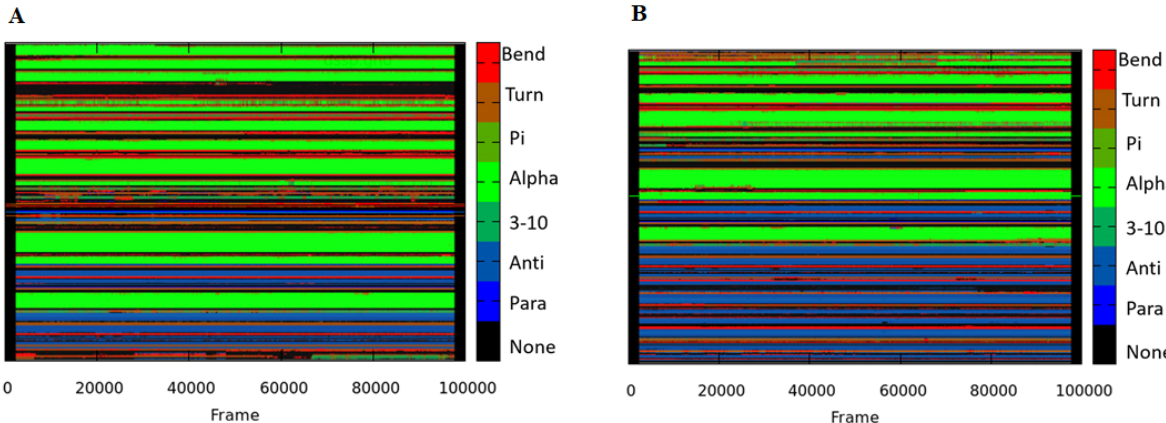
Figure 6. Dynamics cross-correlation matrix analysis ( A ) apo MARK4 enzyme and ( B ) irisin-MARK4 complex calculated after 100 ns of MD trajectories.